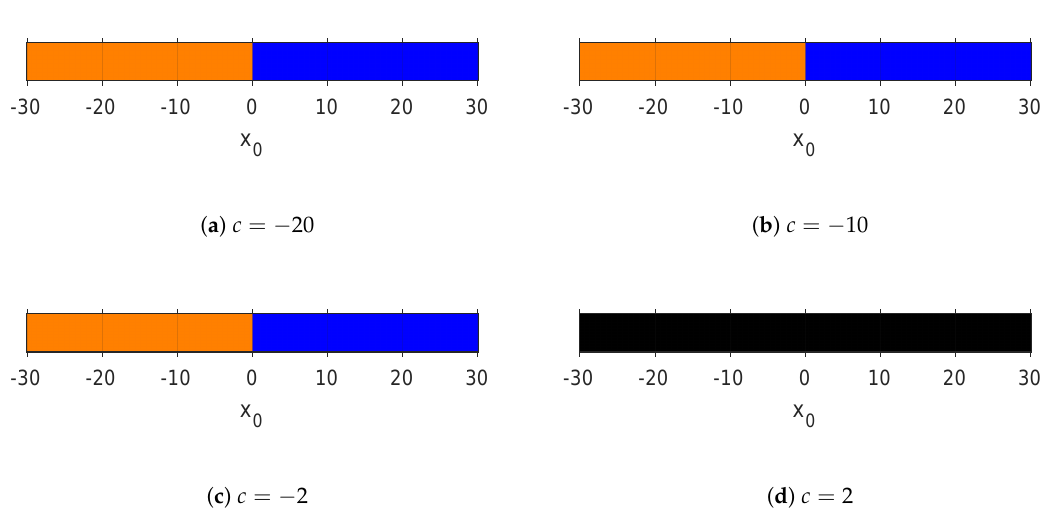
Figure 7. Convergence plane of TM2 method. Color basins: x F points in